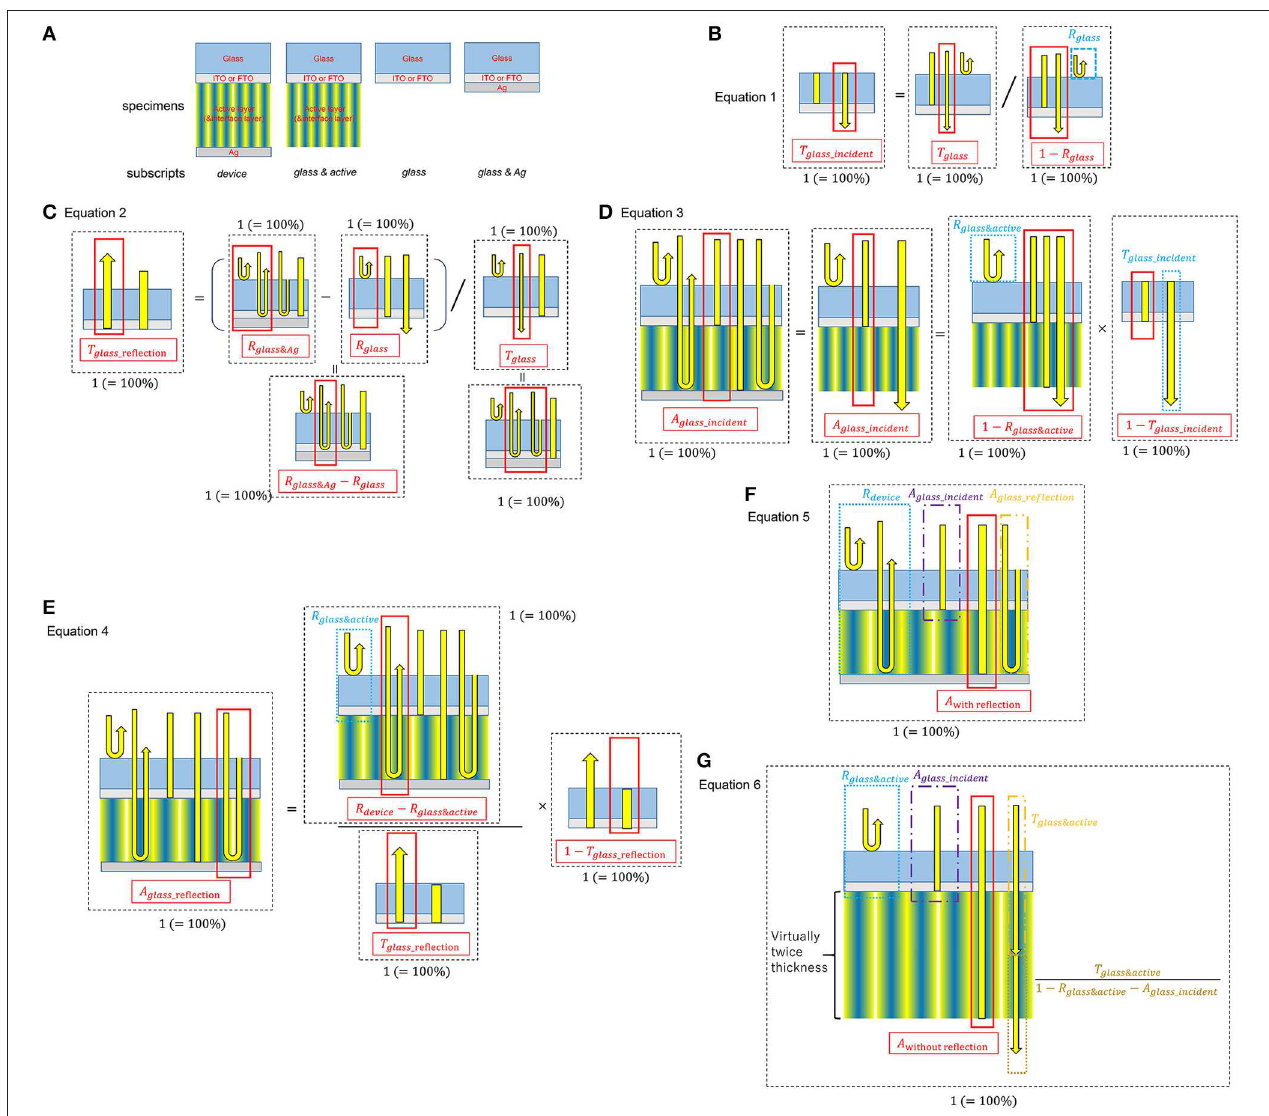
FIGURE 1 | Schematics of optical absorption calculation from transmittance/reflectance measurements. (A) Schematics of the specimens for the measurements. (B–G) are schematics of Equations 1–6,